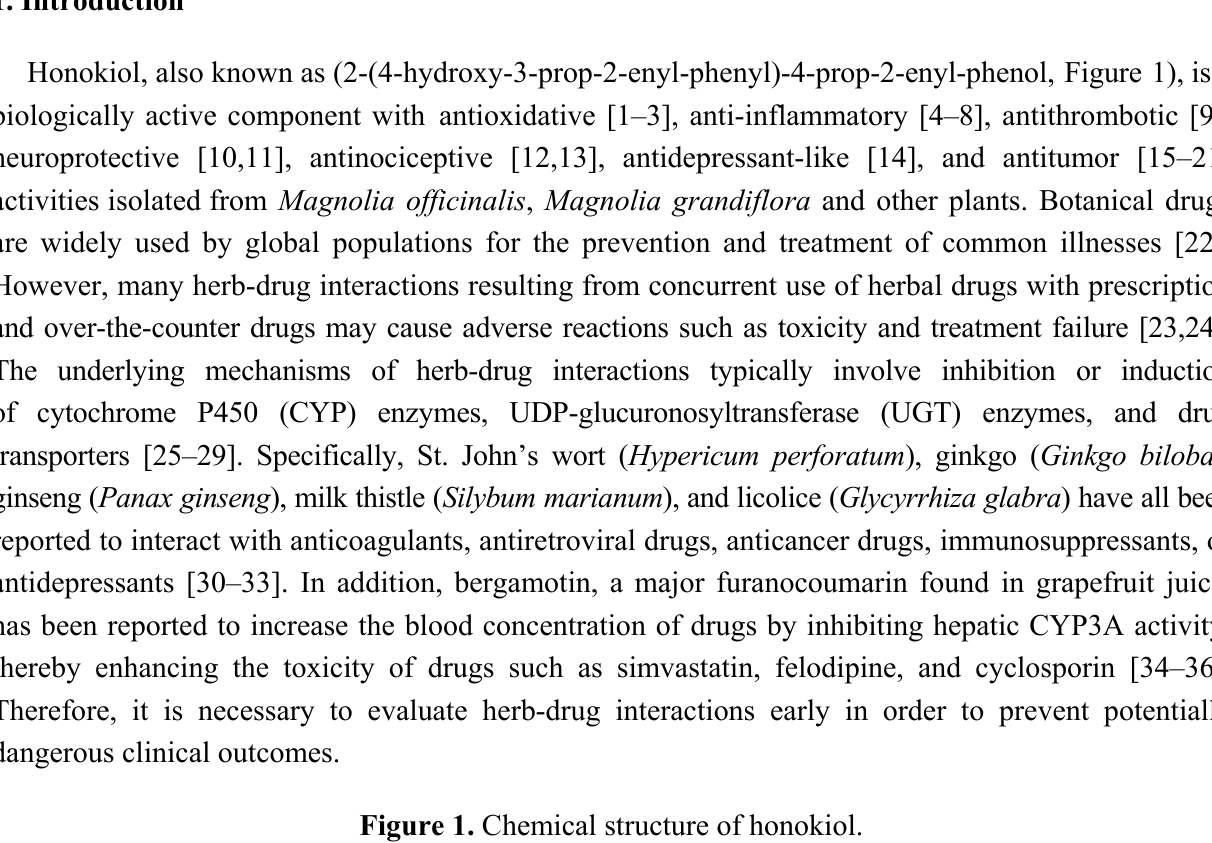
Figure 1. Chemical structure of honokiol.